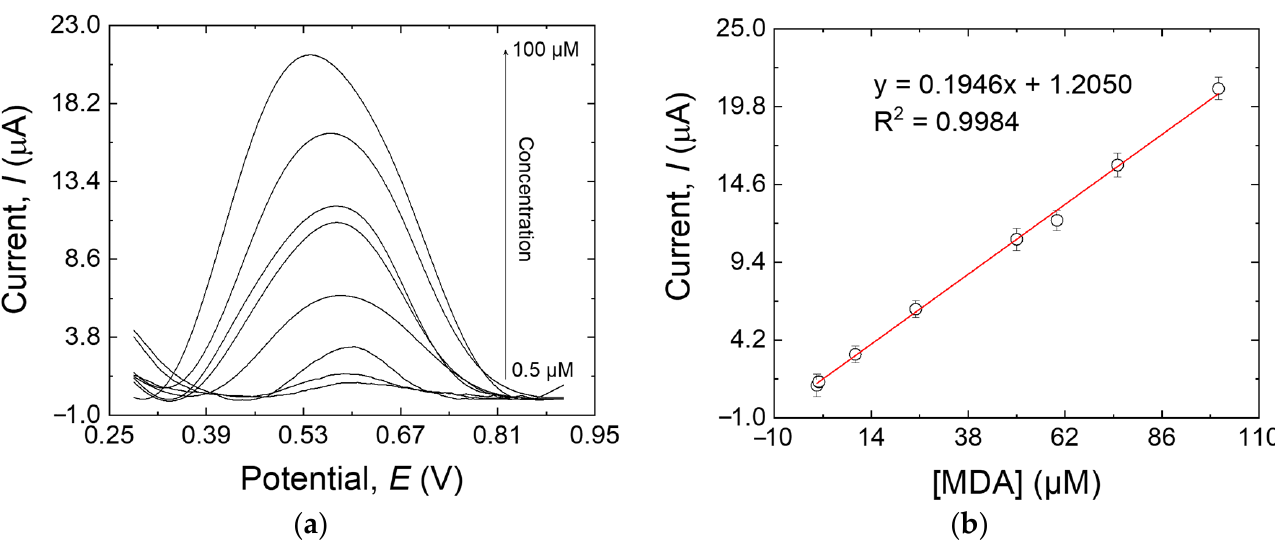
Figure 9. ( a ) DPV responses of the MIP/MWCNTs/GCE at different MDA concentrations: 0.5, 1, 10, 25, 50, 60, 75, and 100 µM; ( b ) the calibration line of the response peak current versus the MDA concentration. Error bars are calculated from three independent replicates.